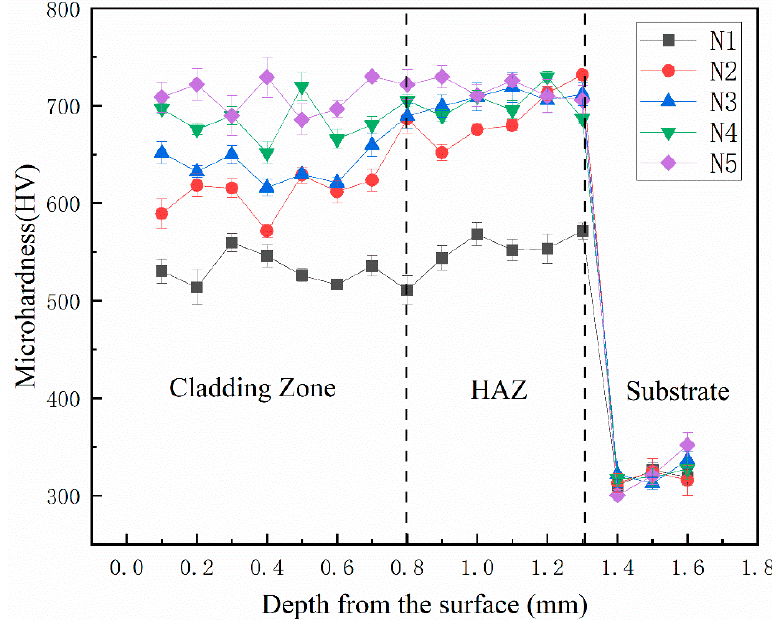
Figure 7. Microhardness of Co-Cr-WC composite cladding layer.